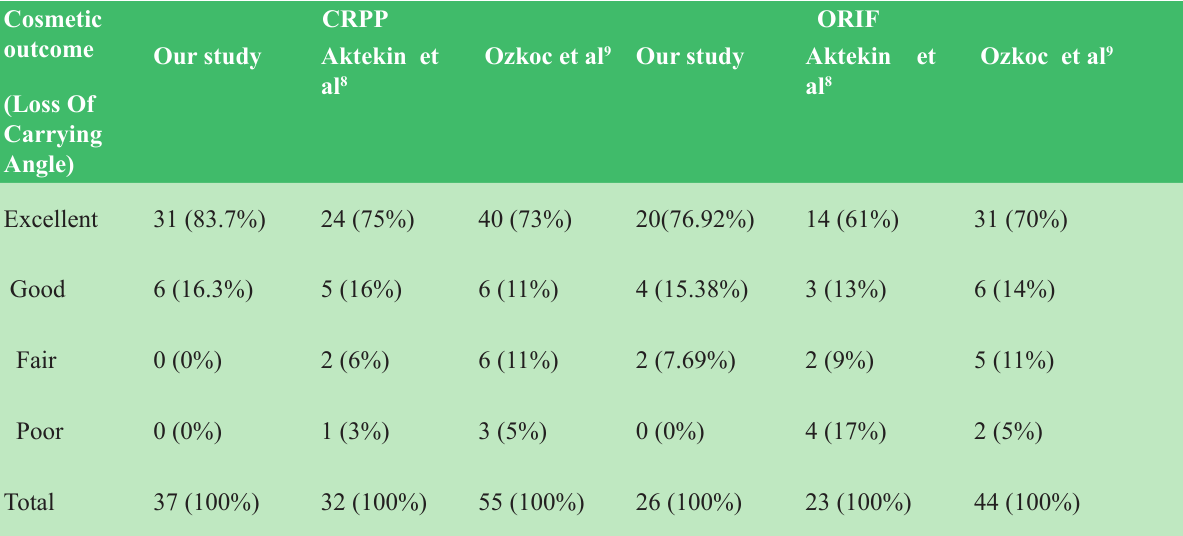
Table 8: Comparison of cosmetic outcome in different studies based on Flynn’s criteria Cosmetic